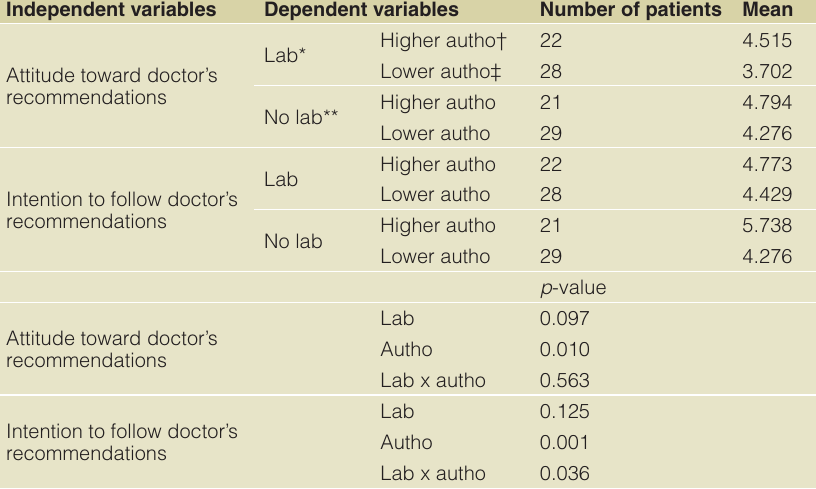
Table 4. Effects of the patient personality ‘authoritarian personality’: results of the two- way analysis of variance (Lab, the laboratory test group; No Lab, no laboratory test group; autho, authority personality).